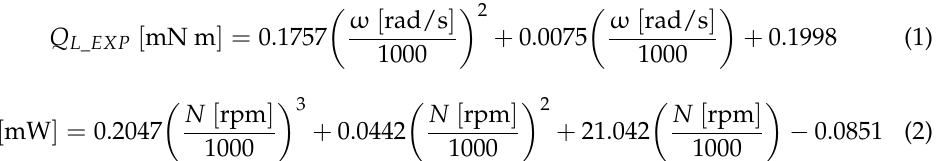
Figure 3. Experimental data of a 3-D-printed miniature rotor measured in Tottori University: ( a ) torque characteristics of the wind turbine and motor load torque; ( b ) torque coefficient; ( c ) power coefficient; ( d ) power as a function of rotational speed.